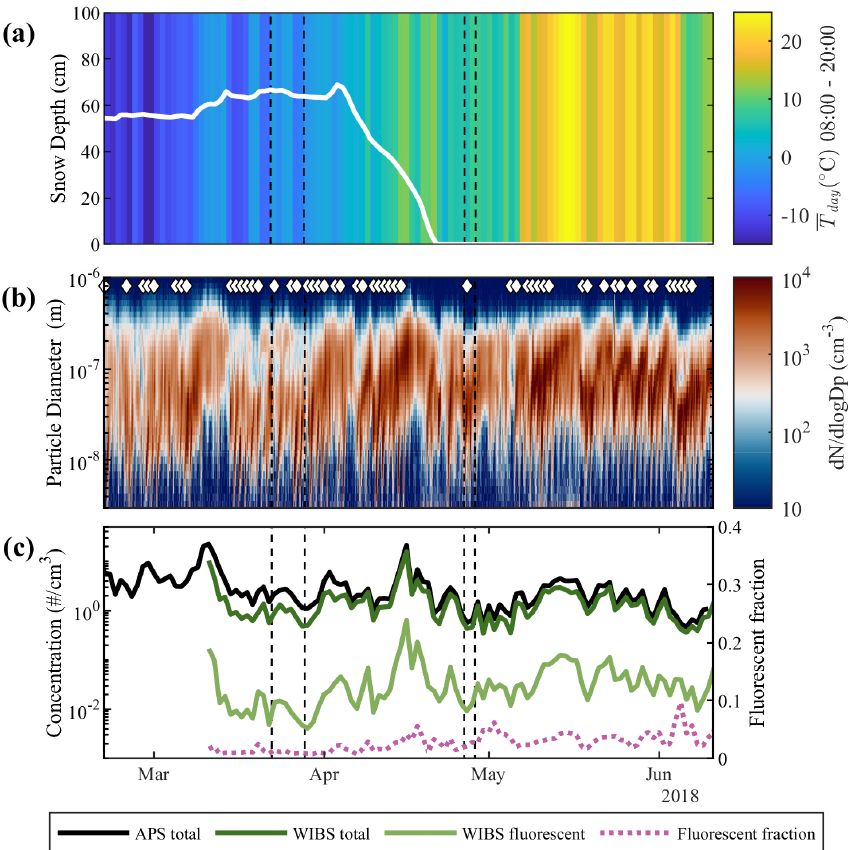
Figure 6. (a) Snow depth (1min resolution, white trace) as a function of time, with the shading representing the mean daytime air temper- ature. (b) Particle number size distribution from the SMEAR II DMPS. NPF events are indicated by white diamonds. (c) daily average of total particle concentration from the SMEAR II APS, total and fluorescent particle concentration from the WIBS and fluorescent fraction ( f = WIBS fluorescent / WIBS total concentration ) as a function of time. See Sect. 2.3.1 for more information concerning the WIBS. In all three panels, the instrument inter-comparison days are indicated by the black dashed